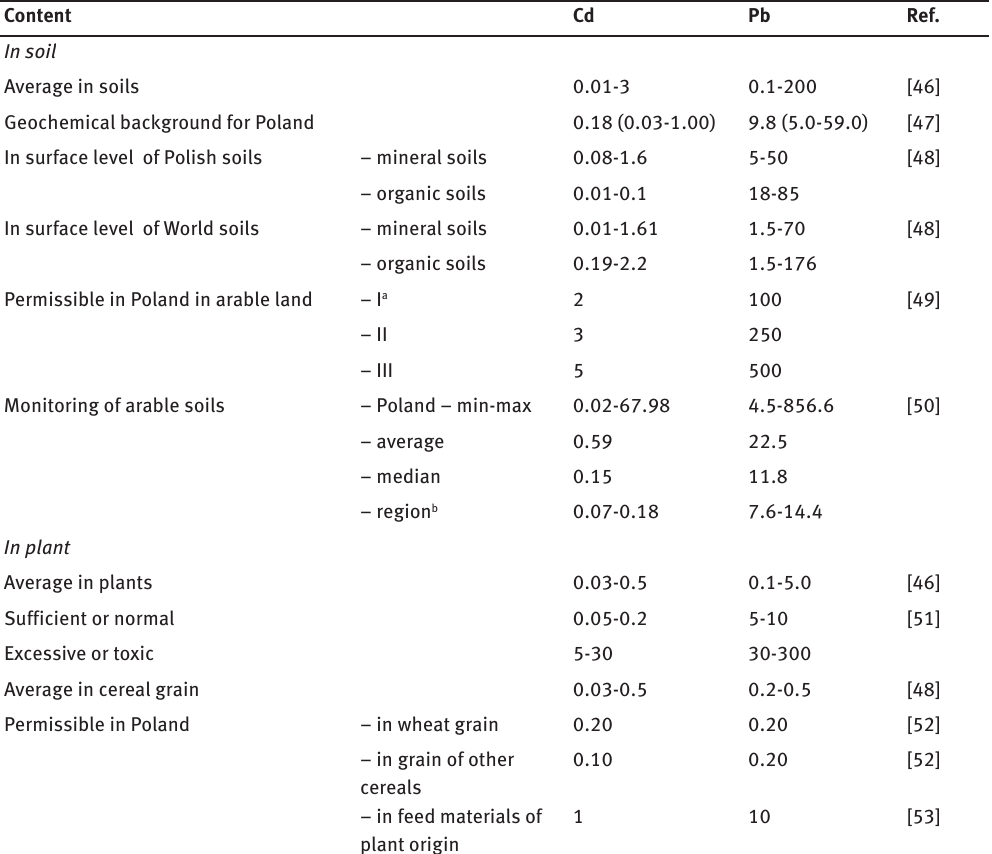
Table 4: Reference values for cadmium and lead contents (mg kg –1 ) of the soil and plants, according to various sources.